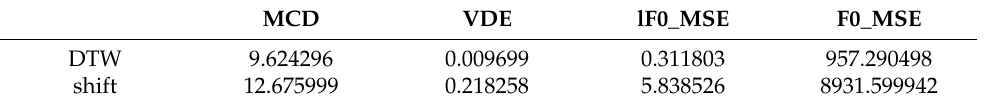
Table 3. Objective measures for the proposed Unsupervised TTS